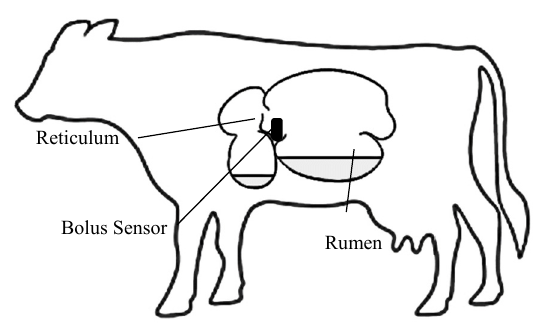
Figure 1. The simplified bovine digestive system and location of the bolus sensor.